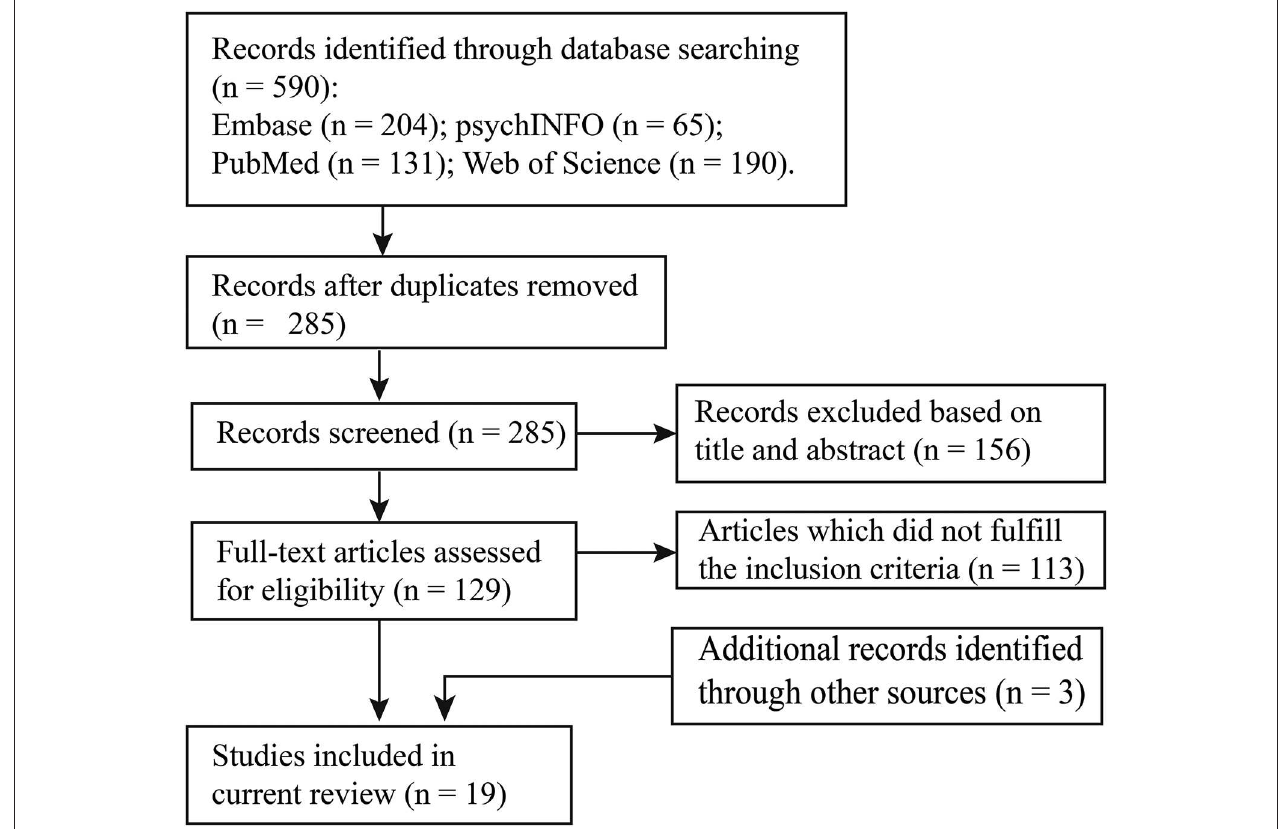
FIGURE 1 | Flowchart of study